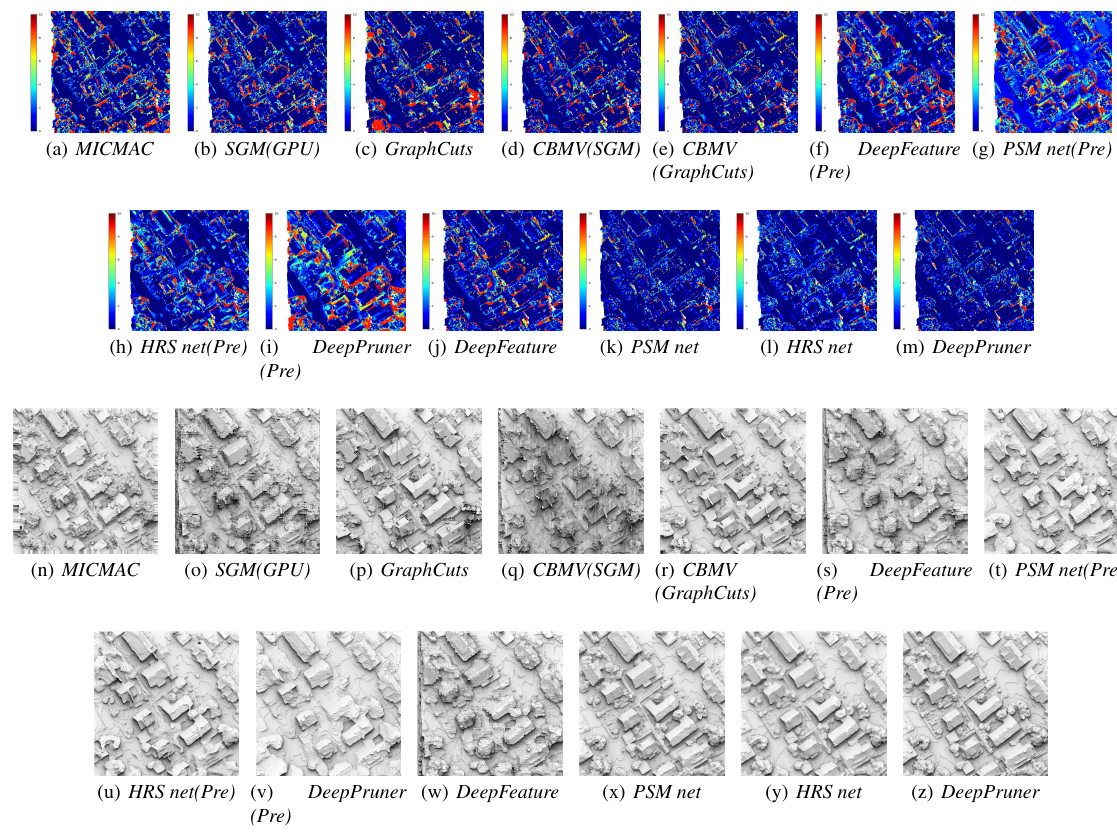
Figure 6. Error map and disparity visualization on building area. From (a)-(m) is the error map, and from (n)-(z) is the disparity map visualization. The left image is shown in Figure